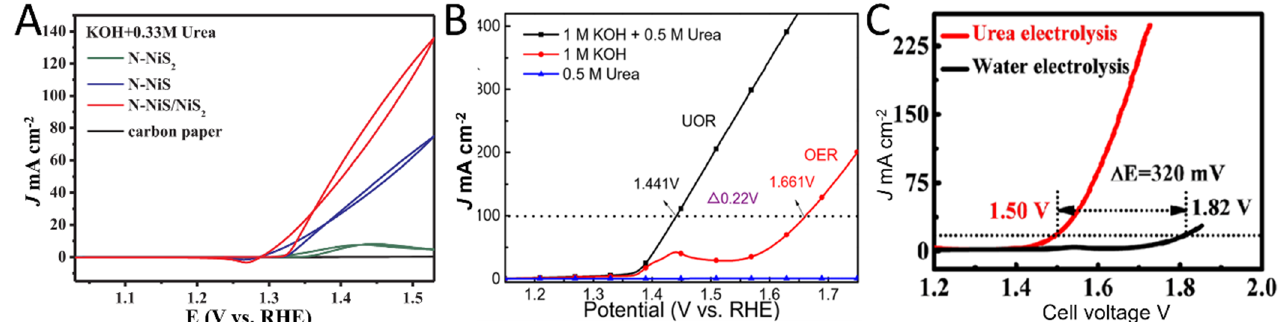
Figure 7. ( A ) UOR performance of sample in 1 M KOH with 0.33 M urea [106]. Reproduced with permission [106]. Copyright 2020, Elsevier B.V. ( B ) UOR curves of MS–Ni 2 P/Ni 0.96 S/NF